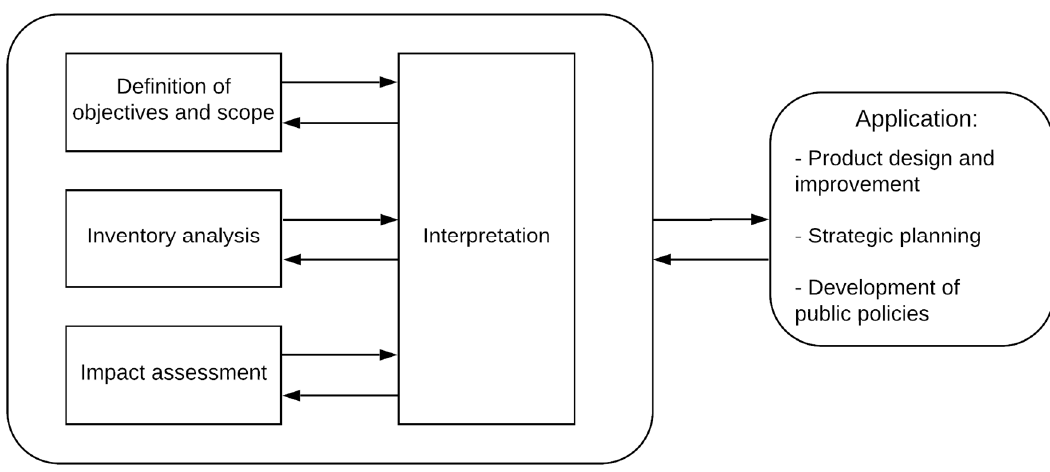
Figure 2. Life cycle analysis framework of reference [22].